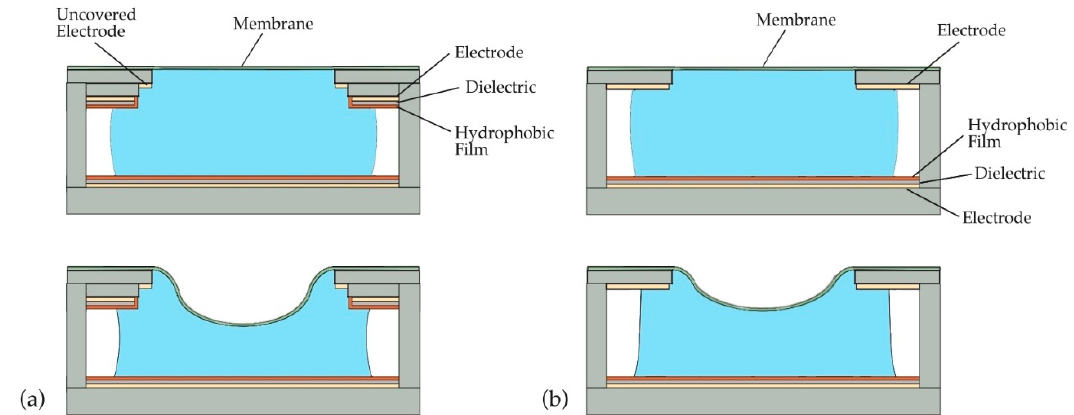
Figure 1. Capillary pressure actuation of a membrane: ( a ) previously investigated dual-active-surface device, before and after application of voltage; ( b ) single-active-surface device examined in this paper, before and after application of voltage. Electrowetting only occurs on the lower surface, not on the upper electrode. This bare electrode can alternatively be placed on the lower surface without changing actuator function.